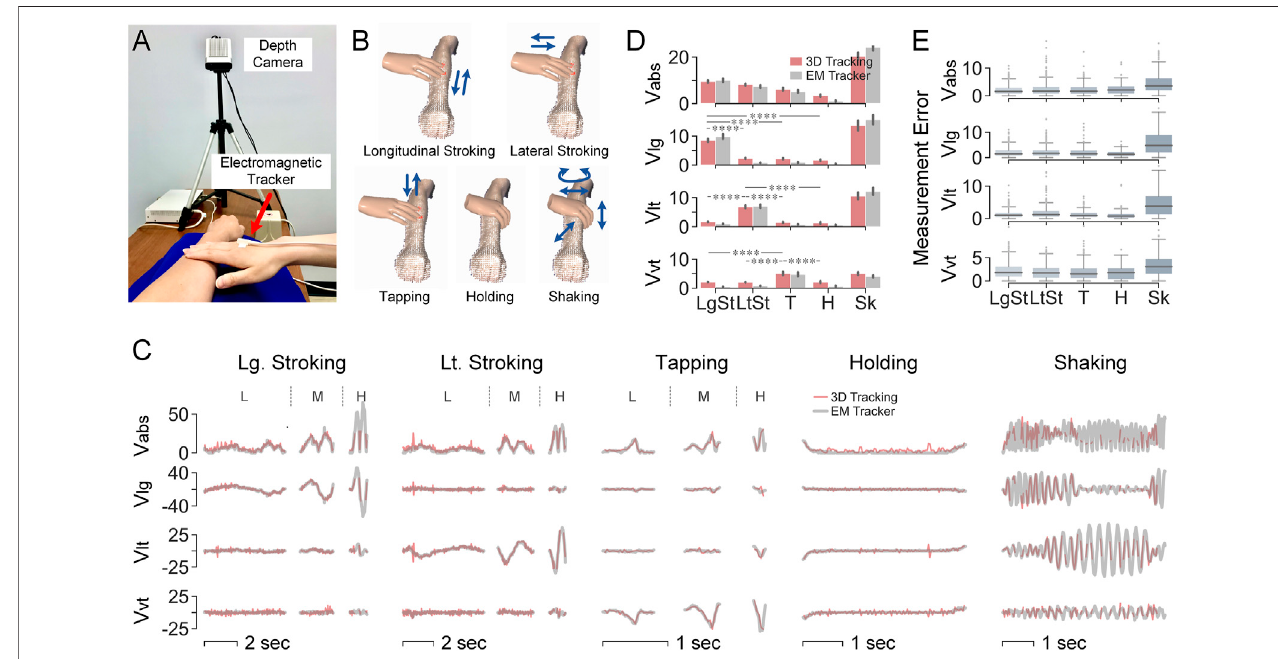
FIGURE 6 | Validation of contact velocity measurements using EM tracker. (A) Experimental setup. (B) Five test gestures. (C) Velocity (cm/s) over time by the two trackingsystems.Forthe fi rstthreetestgestures,onetrialisshownperforcelevel,i.e.,low,medium,andhighforce. (D) Meanvaluesofvelocities(cm/s)pertestgesture. **** p < 0.0001 were derived by paired-sample Mann – Whitney U tests. (E) Errors (cm/s) of measured velocities between the two systems for each test